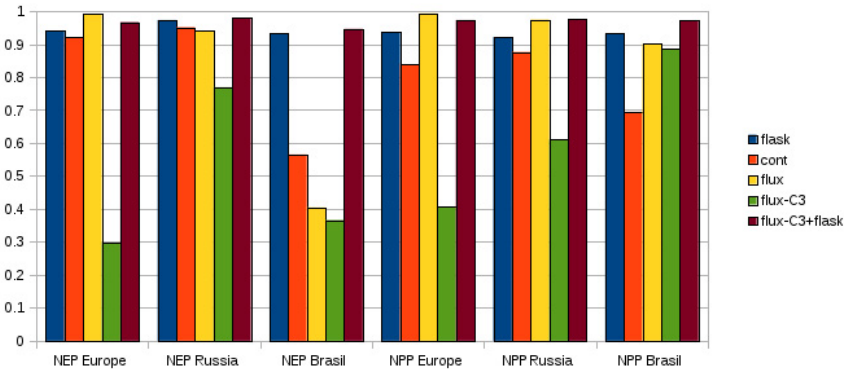
Fig. 7. Evaluation of three base networks, a flux network flux-C3 that is incomplete over Europe and the combined flux-C3 + flask